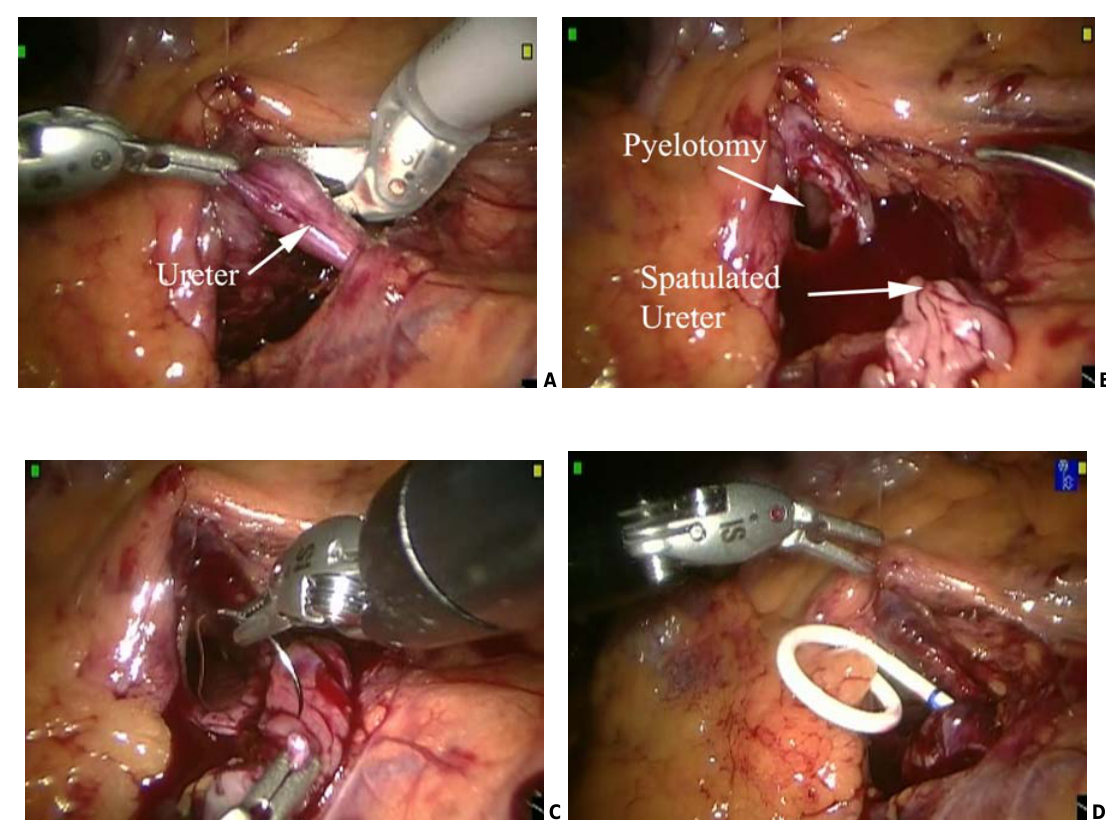
FIGURE 3. Robotically assisted laparoscopic pyeloplasty in a school-age child. Using a transmesenteric approach, the pelvis and ureter can be visualized, and the pelvis is stabilized with a hitch stitch. (A) The pelvis is being opened above the UPJ in order to use the pathological segment as a handle during dissection. It is later removed. (B) The proximal lateral ureter has been spatulated to provide a wide anastomotic segment. (C) Anastomosis of the ureter and pelvis is begun, using 5-0 or 6-0 monofilament absorbable suture. (D) A double-J ureteral stent has been placed for postoperative drainage after the back wall of the anastomosis has been completed. (E) Appearance of the completed anastomosis. The peritoneum over the repair will be